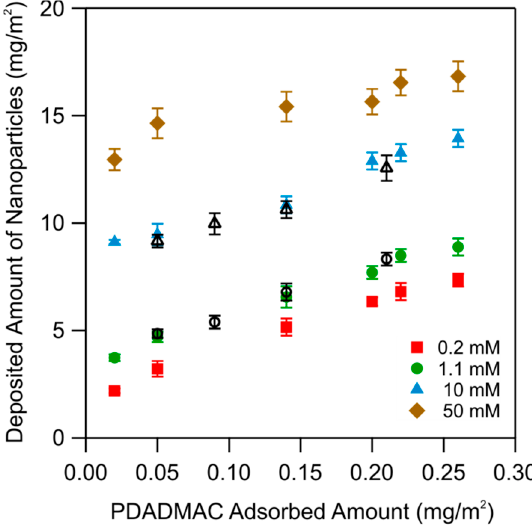
Figure 11. Comparison of the maximum deposited number of nanoparticles on PDADMAC-functionalized surfaces prepared by in situ and ex situ techniques versus the adsorbed amount of PDADMAC. The nanoparticles were deposited at pH 4.0 and the ionic strengths indicated. Full and open symbols refer to in situ and ex situ functionalized substrates, respectively.